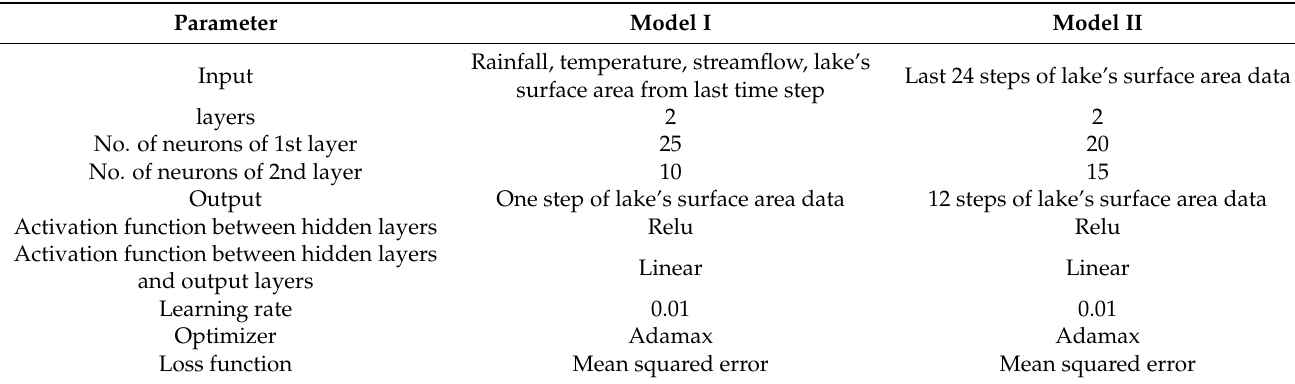
Table 1. Hyperparameters settings of the proposed ANN models.